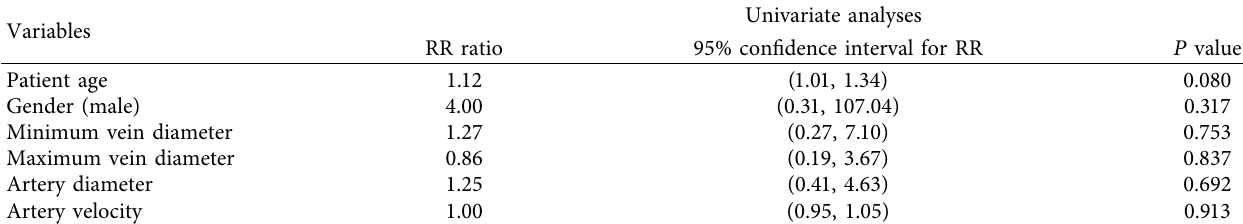
Table 6: Univariate analyses between demographics and vessel measurements on BCF outcomes.